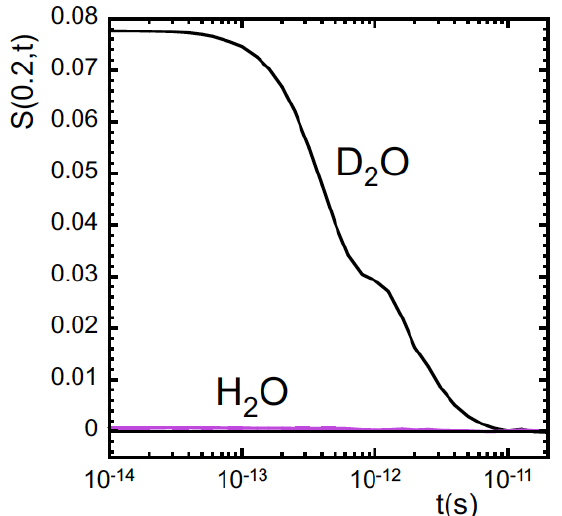
Fig. 5. Coherent dynamic structure factor 𝑆(𝑄,𝑡) corresponding to neutron scattering measurements calculated from the simulations for both D 0 O and H 0 O at Q = 0.2 Å 34